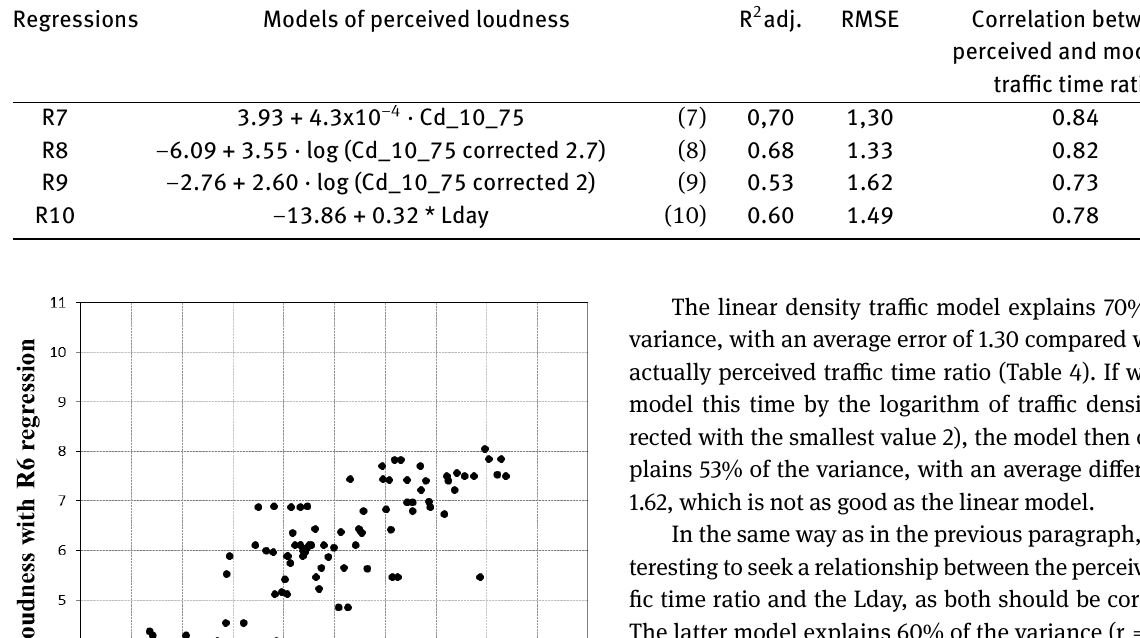
Table 4: Correlations between perceived and modelled traflc time ratio for different linear regressions.